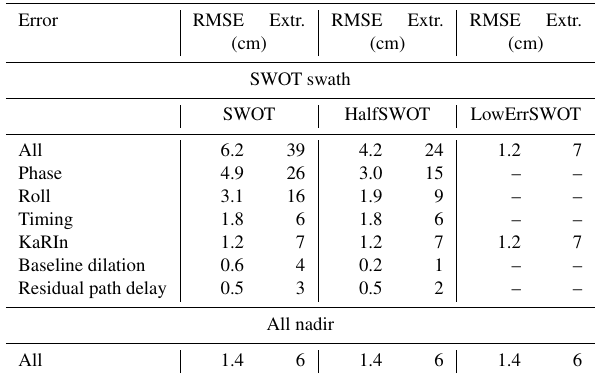
Table 2. SWOT swath and all nadir error statistics (RMSE and ex- trema, cm) for 1 month (July 2017) of simulated observations. Each component of the simulated errors is given for our experimental se- tups with the full-swath (SWOT), half-swath (HalfSWOT) and the uncorrelated-error experiment